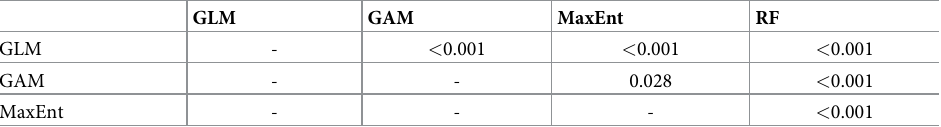
Table 3. Using an ANOVA and then a post-hoc Tukey HSD test, we see significant improvements at a significance threshold of 0.05 between standard regression approaches and machine learning